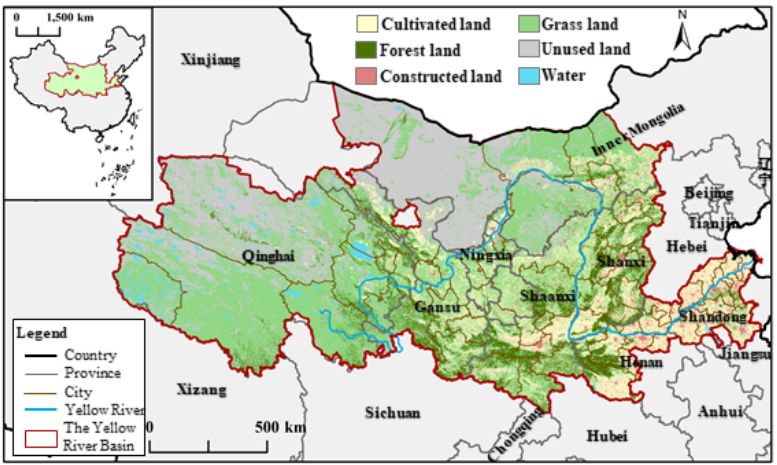
Figure 2. Overview of the Yellow River